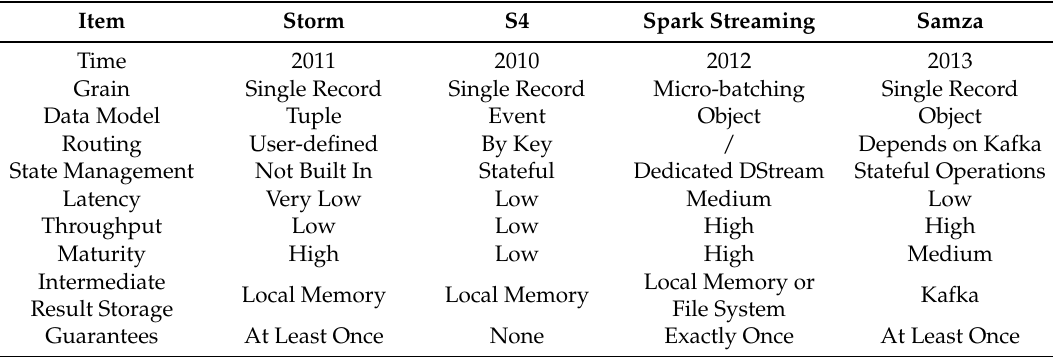
Table 1. Comparison of distributed streaming processing